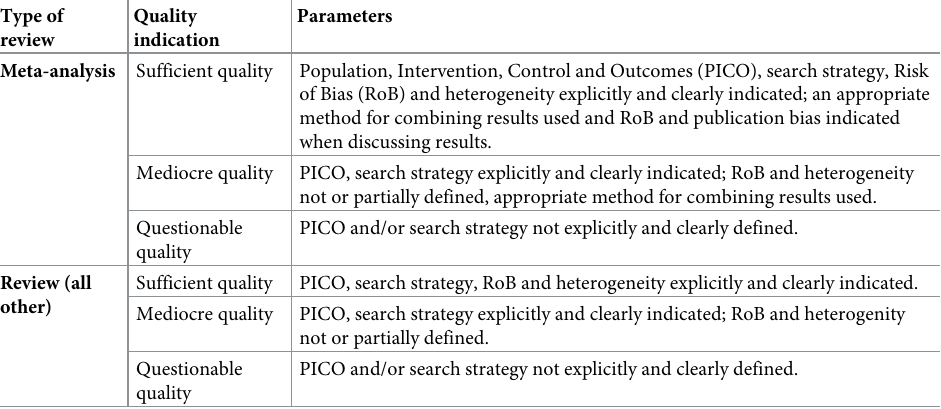
Table 2. Summary of quality scoring of the